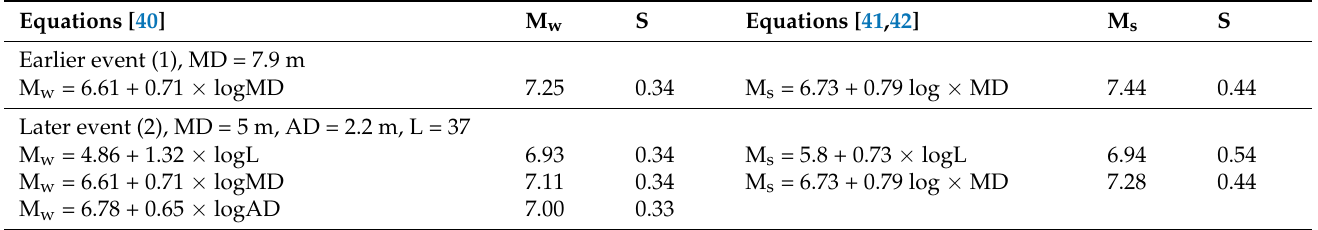
Table 2. Earthquake magnitudes are estimated from empirical equations for normal